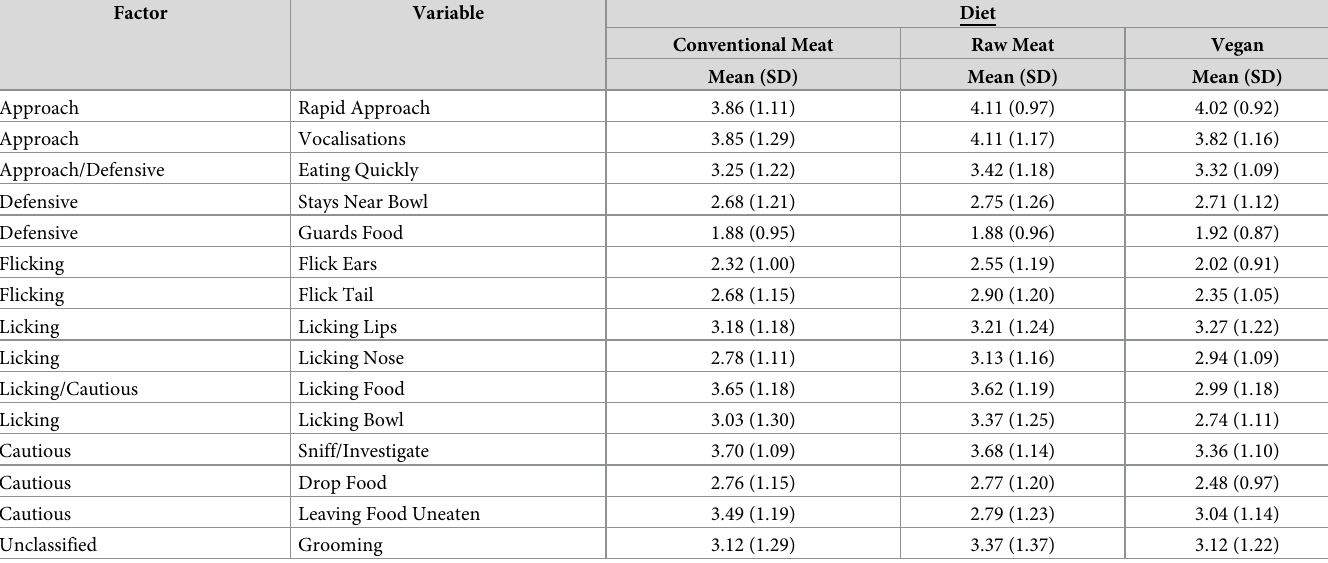
Table 5. Descriptive statistics of the owner reported food-oriented behaviours, with range Strongly Disagree (1) to Strongly Agree (5). Factor